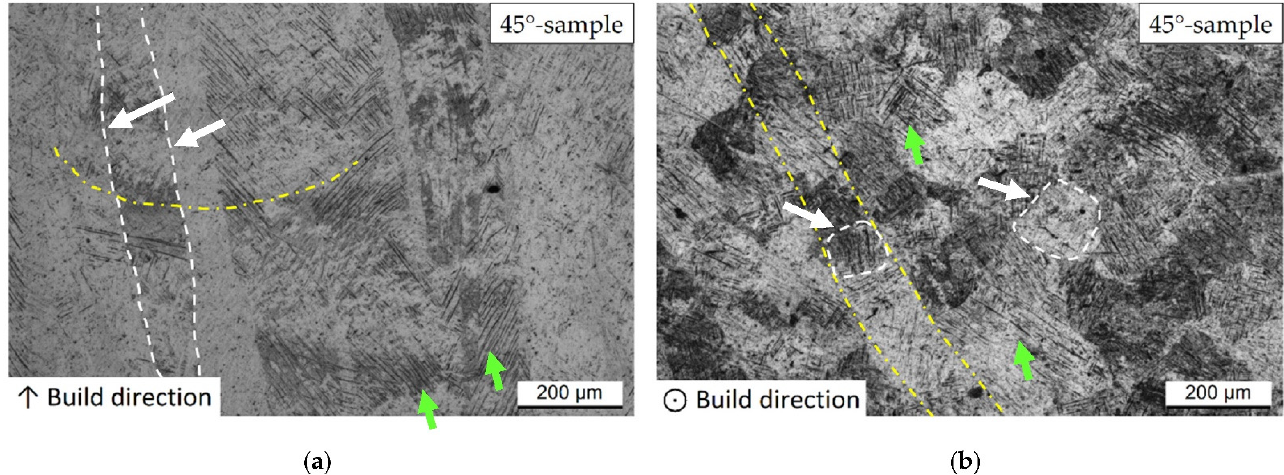
Figure 4. OM micrographs of the microstructure of as-built Ti6Al4V-ELI 45°-sample observed: ( a ) on the plane perpendicular to the build platform, and ( b ) and on the plane parallel to the build platform. White and green arrows indicate the boundaries of the columnar β -grains (white dotted lines) and the laths of α′ -martensite, respectively. The yellow dotted lines represent the molten pool boundary ( a ), and the laser scan tracks ( b ).